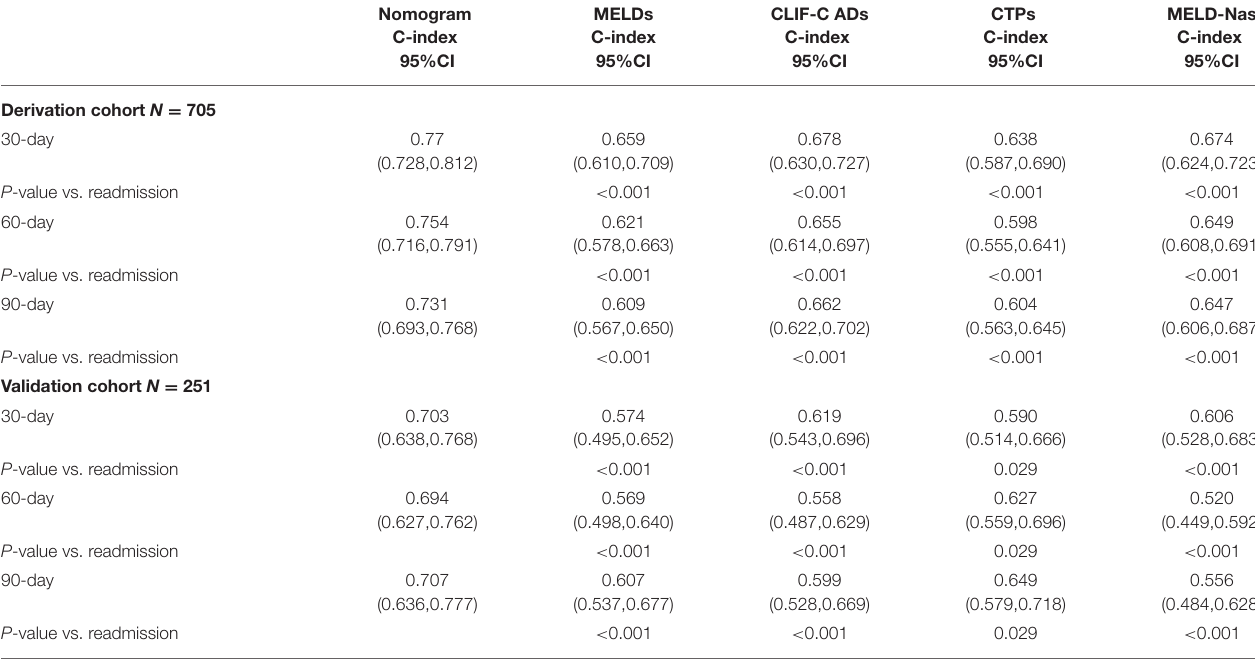
TABLE 3 | Predictive discrimination ability of nomogram as compared to MELDs, CLIF-C ADs, CTPs, and MELD-Nas in the derivation and temporal validation cohort.